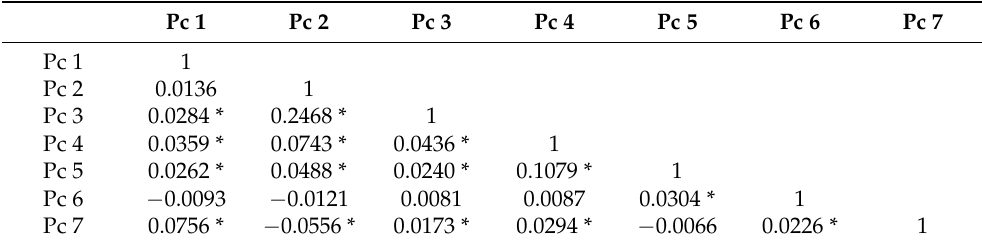
Table 5. Pairwise Correlations of Political Connection